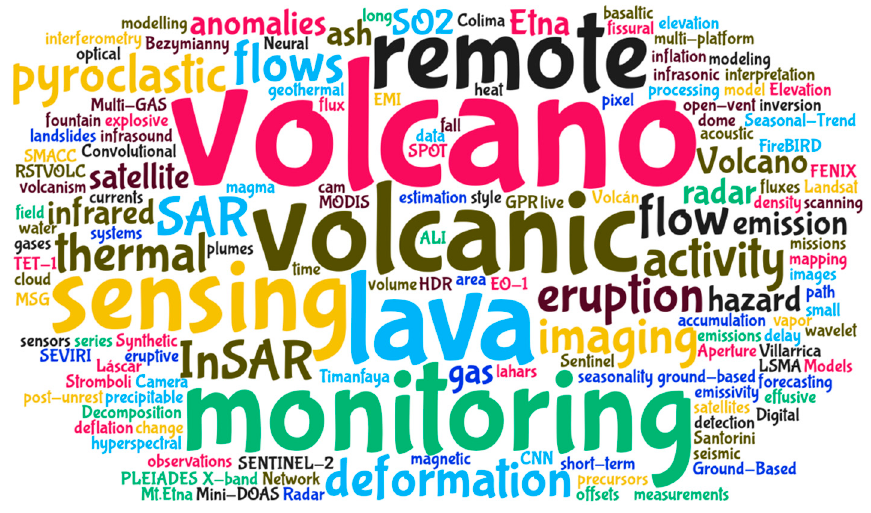
Figure 1. Thematic keywords of the 19 research papers composing the Special Issue “Remote Sensing of Volcanic Processes and Risk” [5] of Remote Sensing (created with wordclouds.com). Table 1. Summary of remote sensing data, methods, and areas of interest discussed in the 19 research papers composing the Special Issue (sorted in ascending order, according to the publication date).